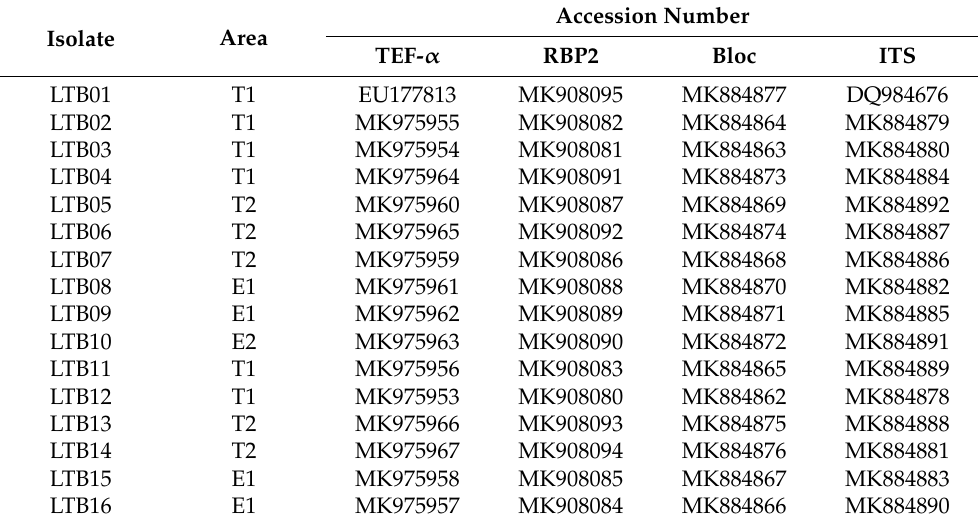
Table 3. Collection site and accession numbers (TEF- α , RBP2, Bloc, and ITS genes) of the representa- tive